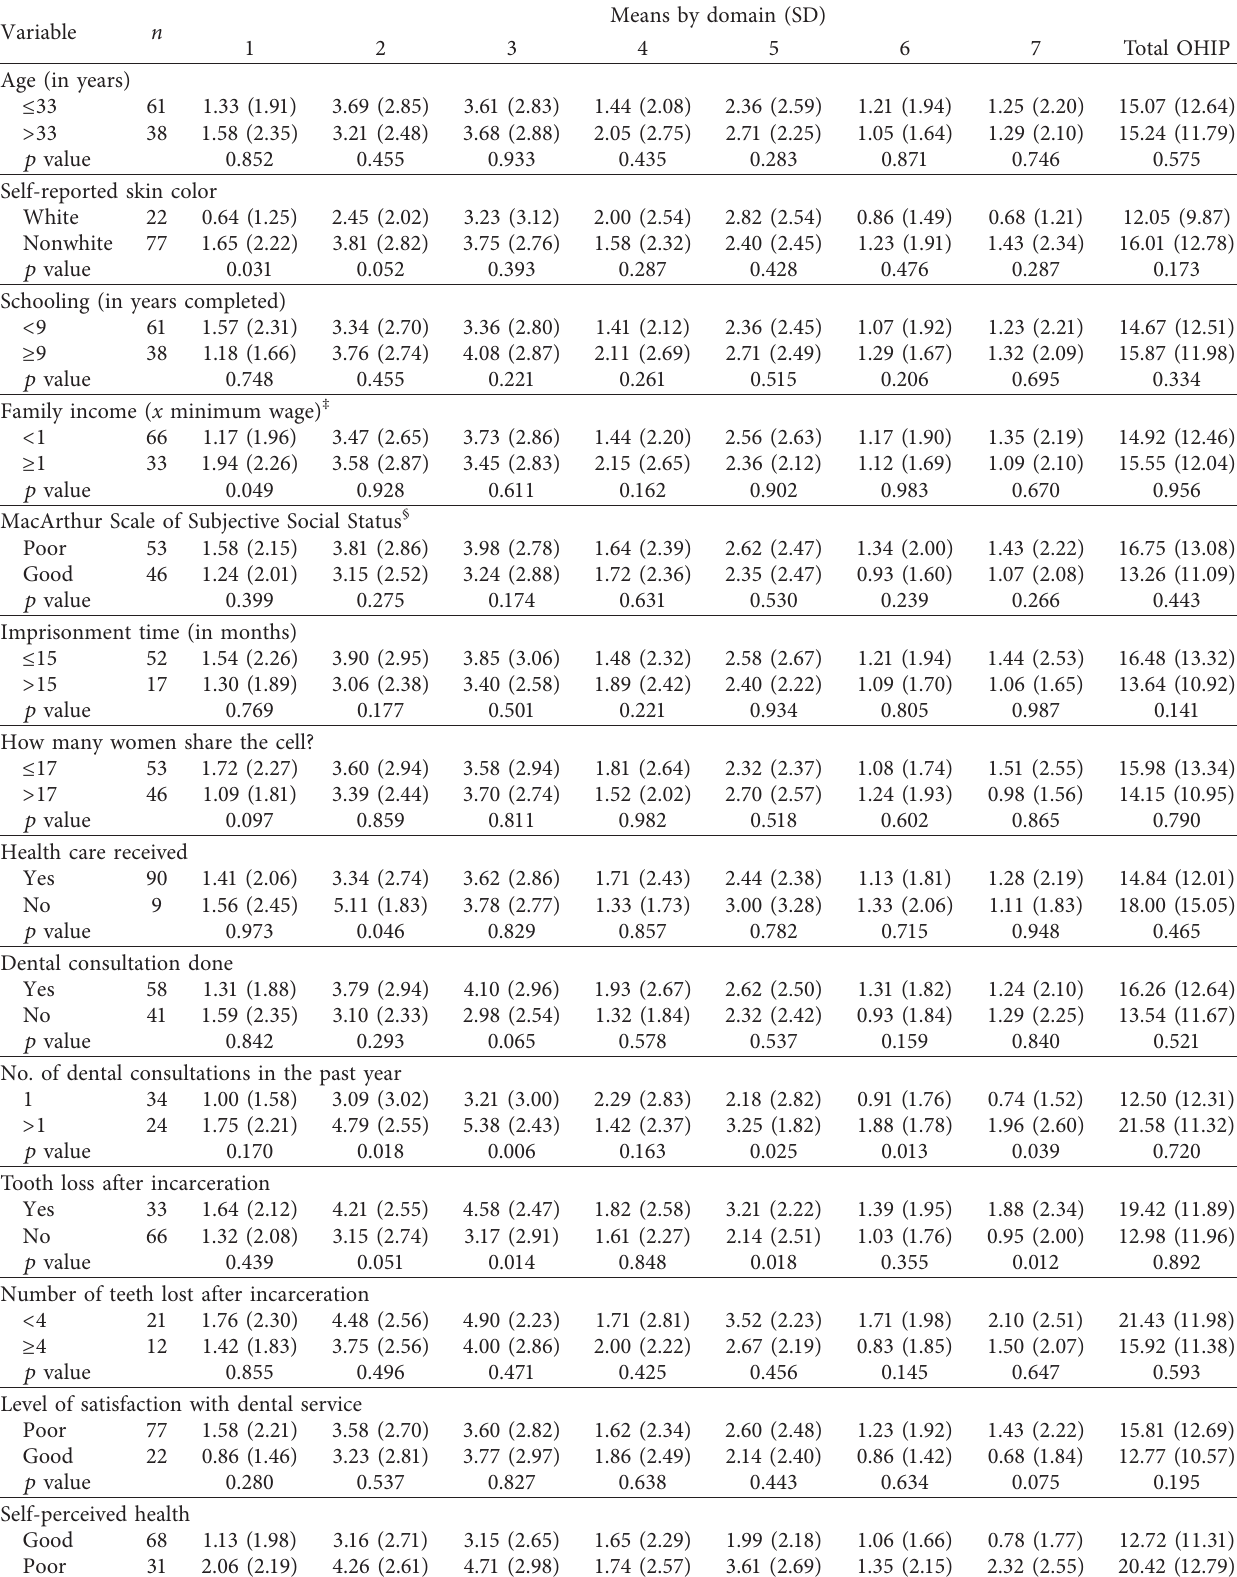
Table 4: Mean, standard deviation, and p value † of the independent variables, by domains and for total OHIP-14 of women inmates in Juiz de Fora,